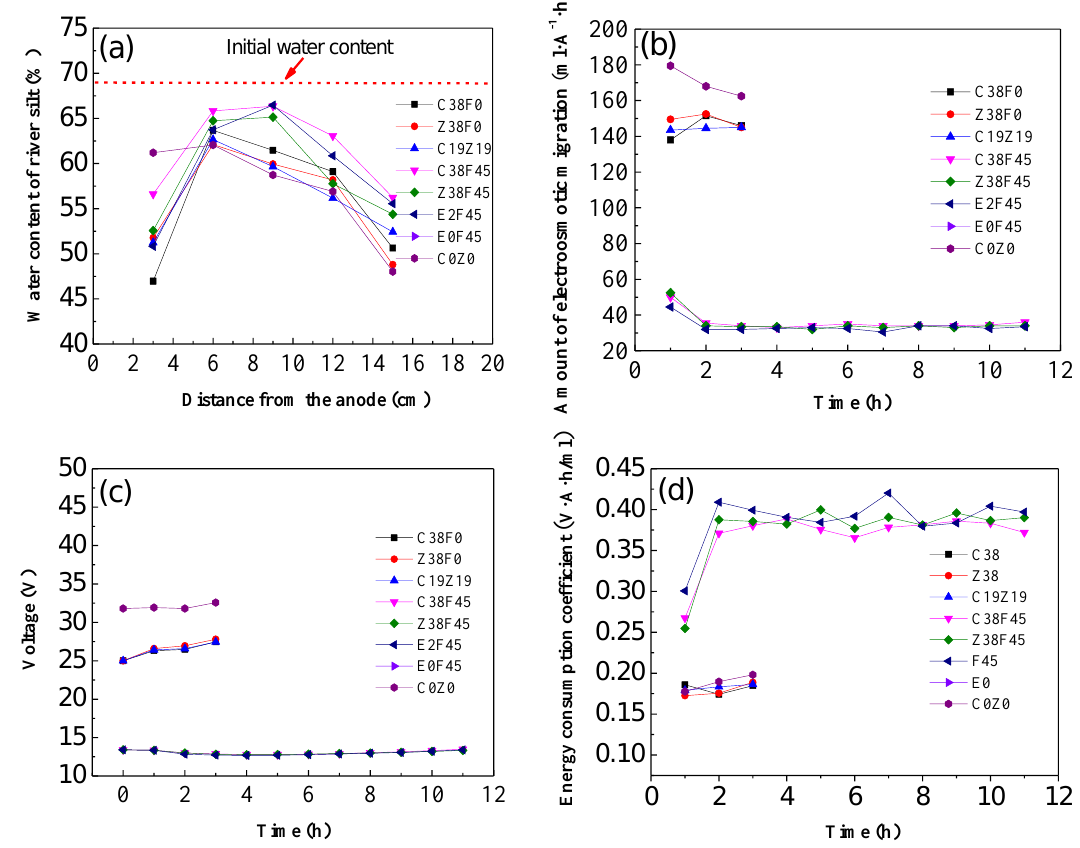
Figure 7. Effects of electro-osmosis treatment on various groups of river sediment. ( a ) Water content; ( b ) Amount of electroosmotic migration; ( c ) Voltage; ( d ) Energy consumption coefficient.